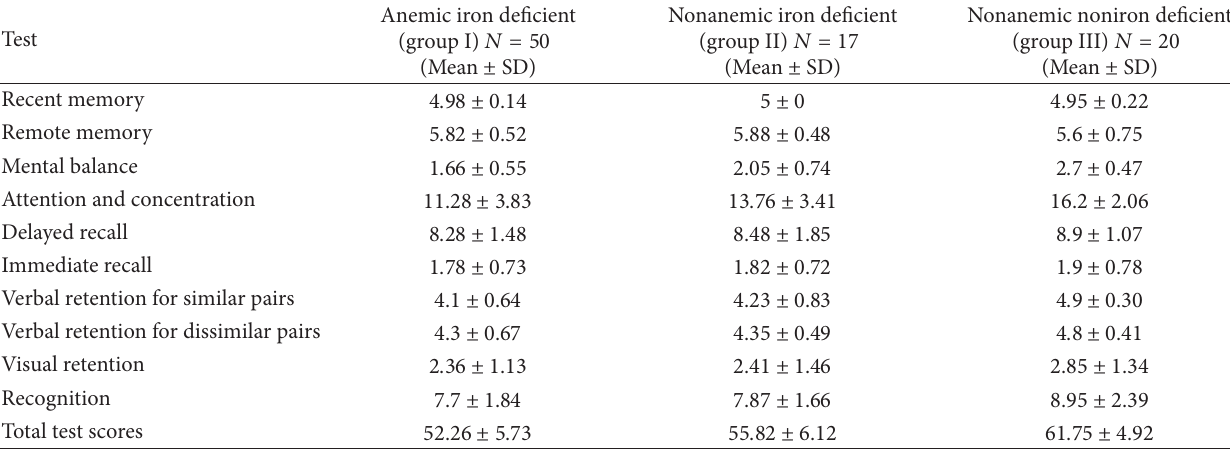
Table 3: The mean multicomponent test (MCT) scores in the three different groups.